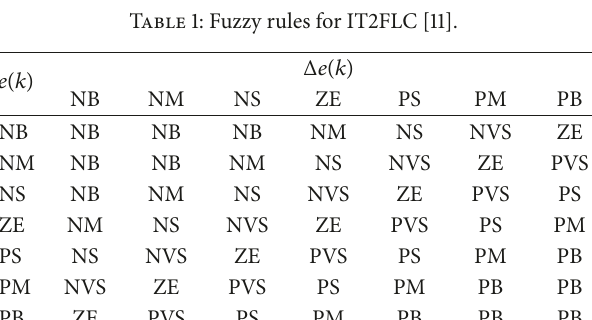
Figure 5: Type-2 fuzzy membership functions of the speed error, their variation, and the control signal.